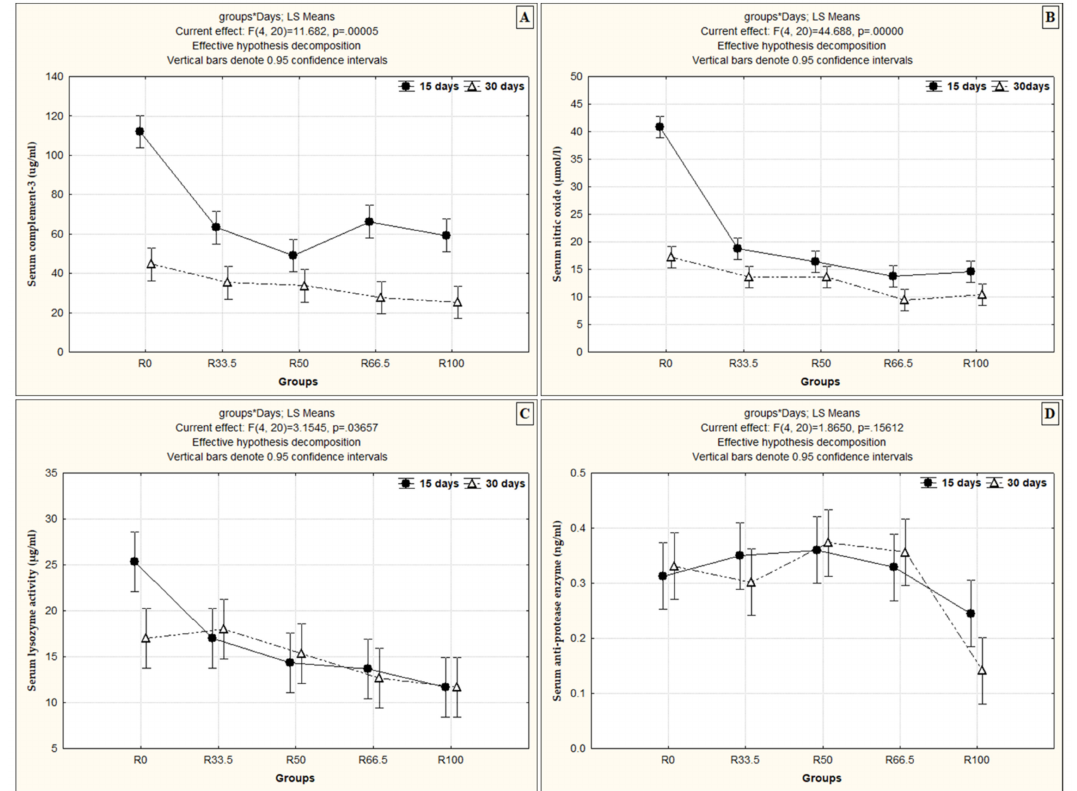
Figure 4. The interaction effect between the levels of fishmeal substitution with plant protein (soybean and sunflower meal) and feeding duration ( p < 0.05, using two-way ANOVA) on ( A ) serum complement-3 (ug/mL), ( B ) serum nitric oxide ( µ mol/L), ( C ) serum lysozyme activity ( µ g/mL) and ( D ) serum anti-protease enzyme (ng/mL). R0, R33.5, R50, R66.5 and R100: see legend of Figure 1.